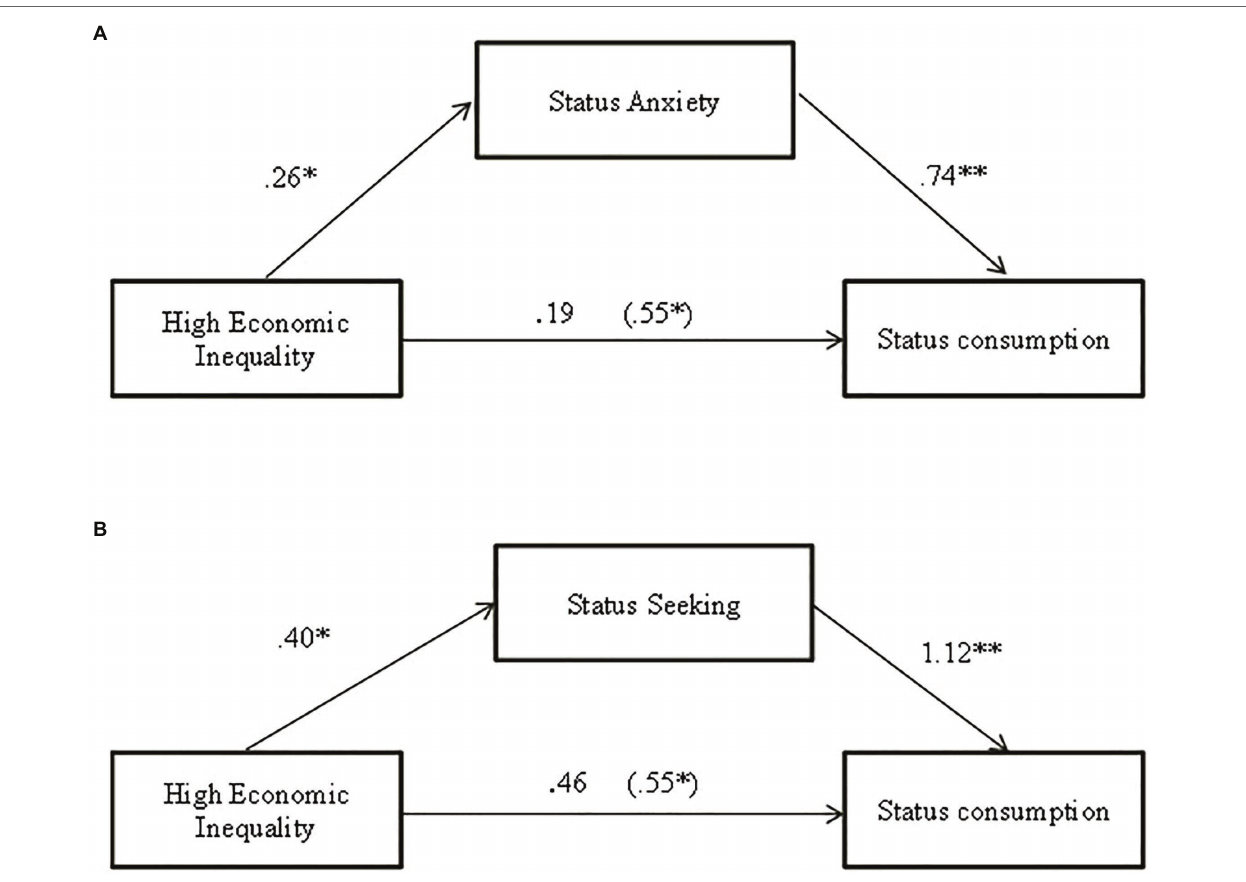
FIGURE 3 | Indirect effect of economic inequality condition on status consumption through status anxiety (A) and status seeking (B) in Study 1. Coefficients are standardized: total effect in parenthesis; * p < 0.05; ** p < 0.001.